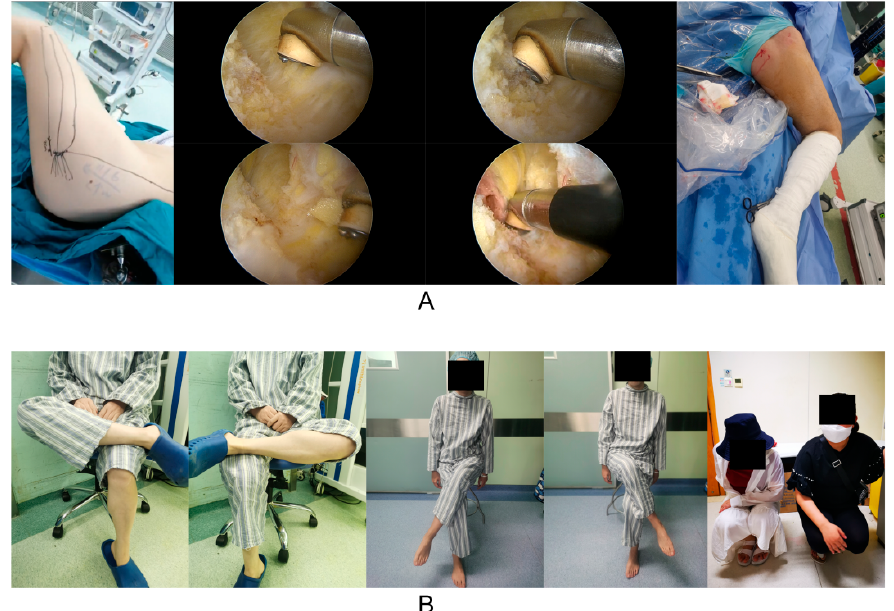
Figure 4. ( A ) During arthroscopic GMC release, severe contractures of the muscles and fascia could be seen under a microscope. ( B ) After surgery, the hip ROM was improved, and the patient could easily cross his legs and squat with both knees together.